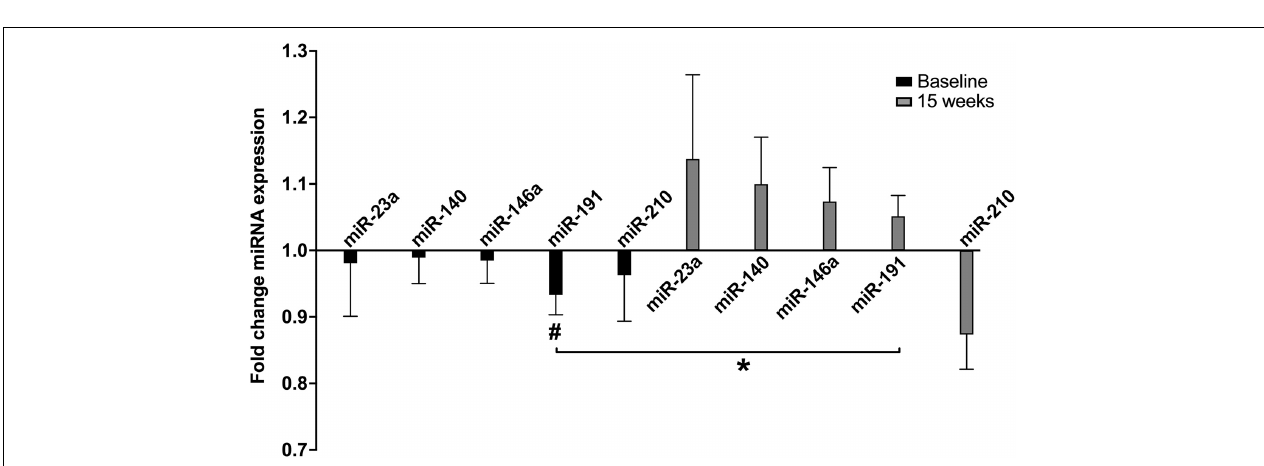
FIGURE 2 | Effect of 15 weeks of training on plasma levels of miRNAs in ET compared to 15 weeks of follow-up in UC. Data are expressed as the mean logarithm of the relative expression of the respective miRNA ± SD at baseline and after 15 weeks. Each line represents the change in plasma miRNA levels with 15 weeks of training in ET ( n = 25) and 15 weeks of follow-up in UC ( n = 21).